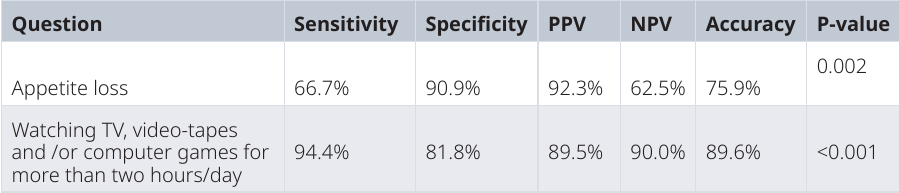
Table 9. Validation with anthropometric measures of the questions which have highest sensitivity and specificity and accuracy with the SGA.